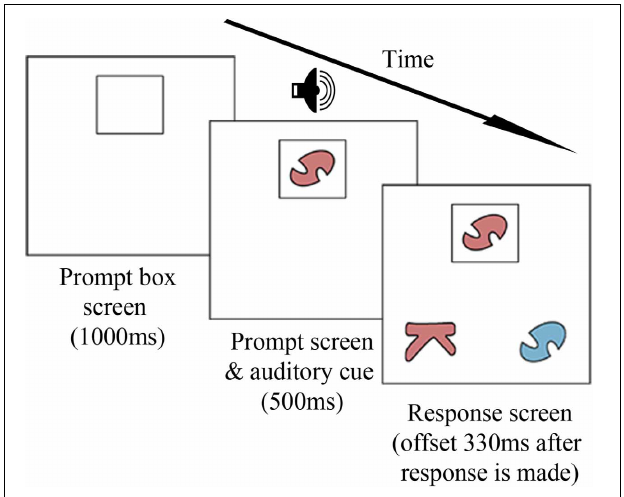
FIGURE 1 | Trial procedure. The prompt stimulus ( top ) matches one response stimulus (bottom left ) according to its color and the other response stimulus (bottom right ) according to its shape. An auditory cue (“color” or “shape”) is onset concurrently with the prompt